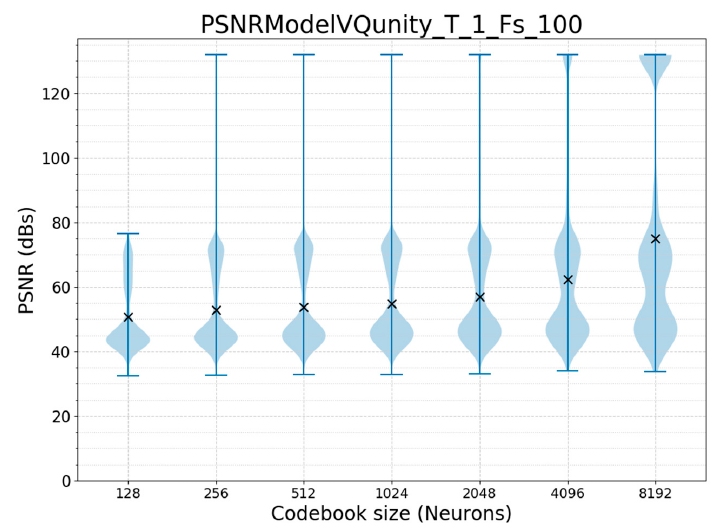
Figure 10. PSNR distribution and mean value (x) vs. codebook size N for the frequency sensitive competitive learning (FSCL) model (F = 100 Hz, T = 1 s).